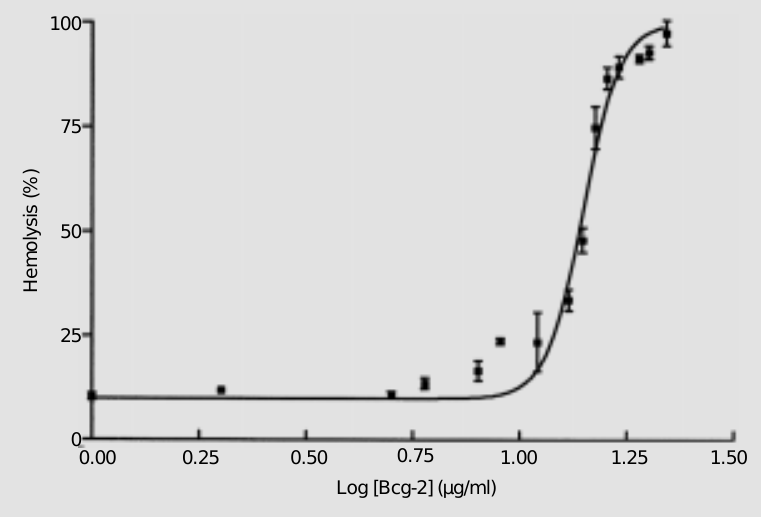
Figure 2. Cytolytic activity of fraction Bcg-2 on mouse erythrocytes. The data were fitted to a sigmoid dose-response curve (EC 50 = 14 µg/ml; maximum dose = 22 µg/ml). Percent hemolysis was measured at 540 nm and compared with the hemolytic effect of Triton X- 100. Data are reported as means ± SEM of percent hemolysis (N =